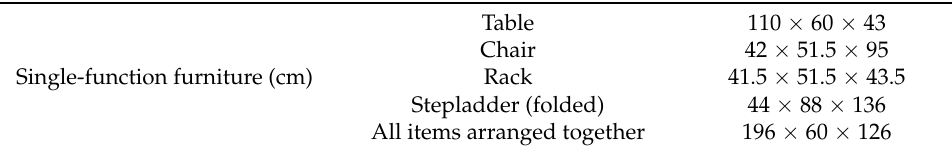
Table 17. Dimension measurement results.